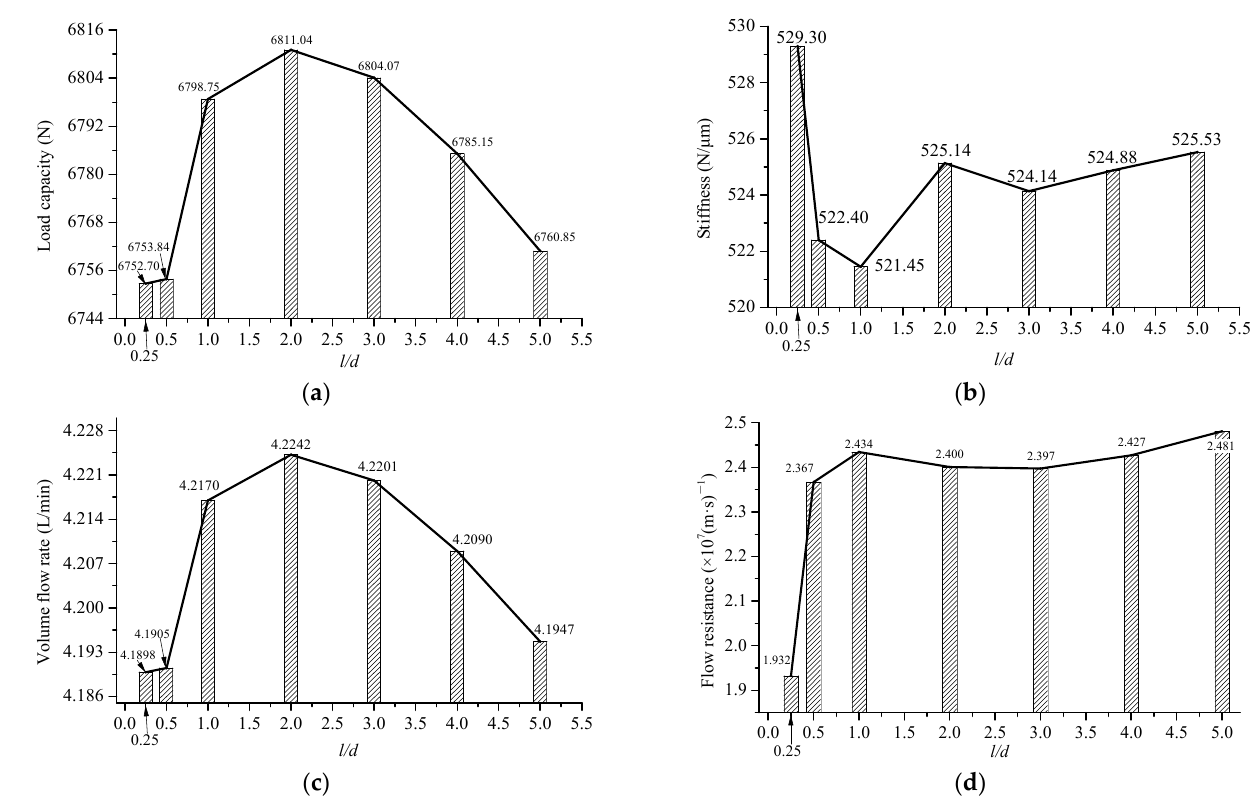
Figure 13. Performance characteristics of the bearing for various OLDRs. ( a ) Load capacity; ( b ) oil film stiffness; ( c ) volume flow rate; ( d ) flow resistance of the orifice.